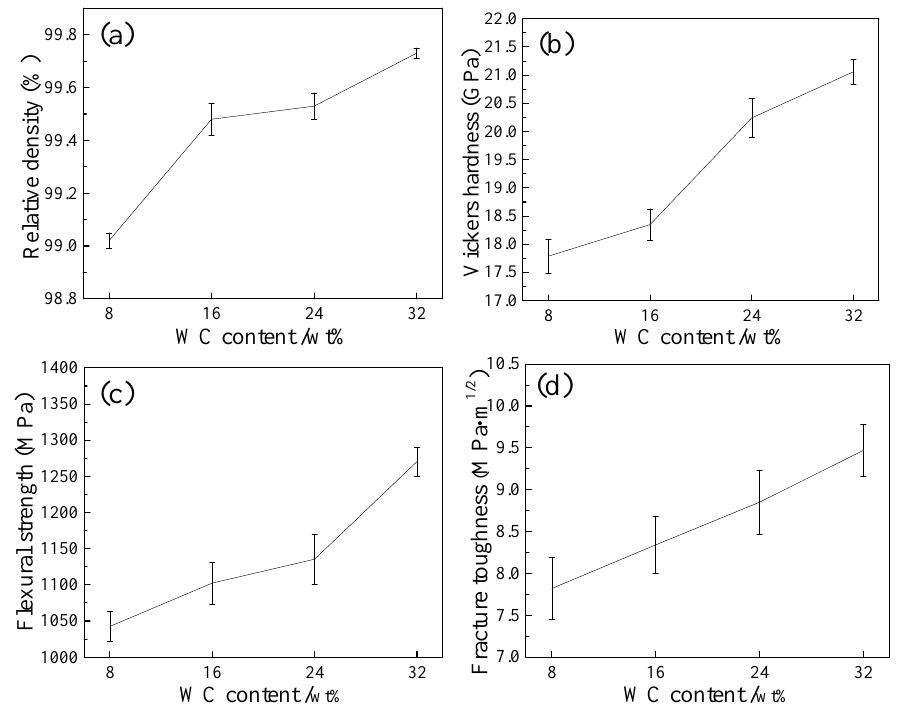
Figure 5. Relative density and mechanical properties of TiC 0.7 N 0.3 ‐ HfC ‐ WC ‐ Ni ‐ Mo cermet tool materials with different WC contents: ( a ) relative density; ( b ) Vickers hardness; ( c ) flexural strength; ( d ) fracture toughness.